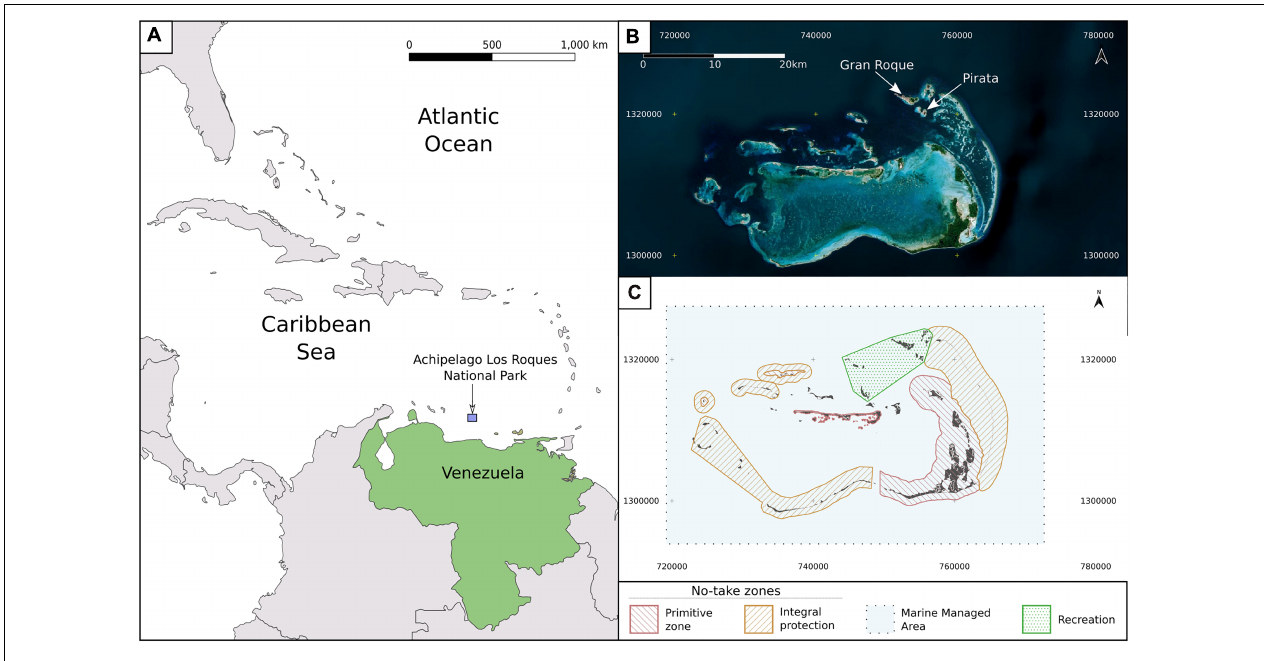
FIGURE 1 | Archipielago Los Roques National Park, a Venezuelan multi-use MPA in the southern Caribbean (A) . Stellite image of the MPA is shown in panel (B) , while the zoning, according to use regulations established in 1991 are shown in panel (C) . Based on allowed activities the marine zones from higher to lower protection are: Integral Protection (IPZ), Primitive Area (PA), Marine Managed Area (MMA – corresponding to the extent not included in the other zones) and Recreation (RZ). Image contains modified Copernicus Sentinel data [2020], processed by ESA. Datum: EPSG: 2202 – REGVEN/UTM